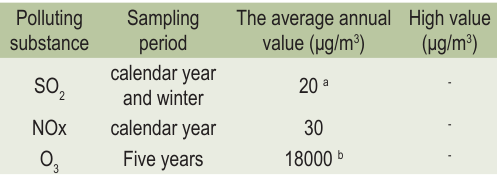
TABLE 2. Limit values (LV) of air in order to protect the eco- system are: